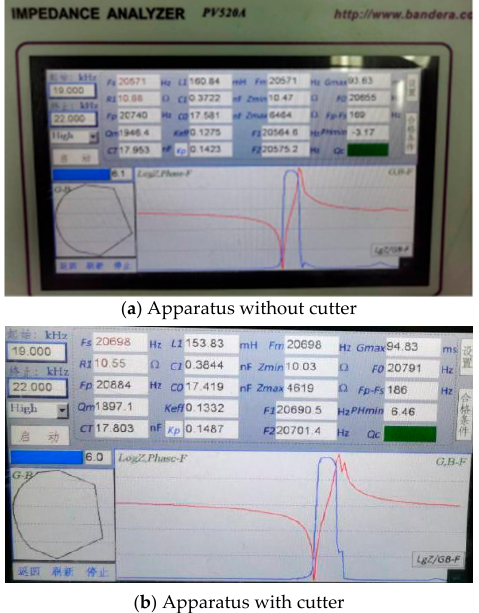
Figure 8. The testing origin data of ultrasonic vibration apparatus.